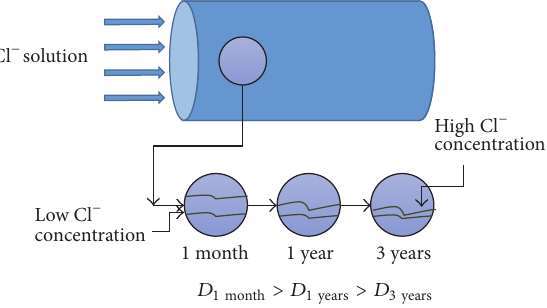
Figure 1: Effect of time on chloride diffusion coefficient [9].